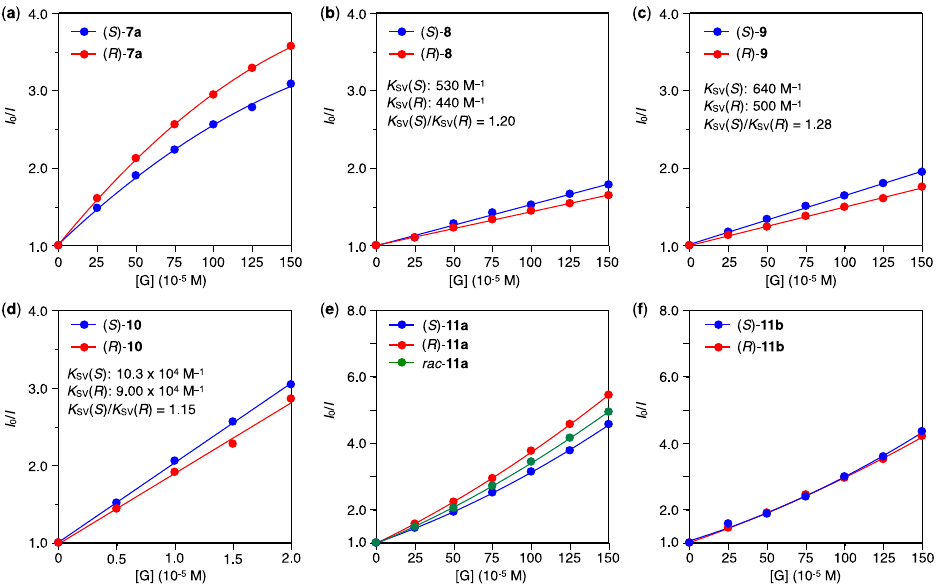
Figure 7. Stern–Volmer plots for the fluorescence quenching of CyD- 1b ( λ ex = 450 nm) by the ( R )- (red) and ( S )- (blue) isomers of 7a ( a ); 8 ( b ); 9 ( c ); 10 ( d ); 11a ( e ) and 11b ( f ) in hexane/THF (90/10, v / v ) at room temperature. The result using rac - 11a as a quencher is also shown in ( e ). [Glucose unit] = 1.0 × 10 − 5 M. The influence of the fluorescent terthienyl-based pendant on the chiral recognition was investigated by comparison of the chiral recognition abilities of Am- 1b and the previously reported amylose tris(phenylcarbamate) (ATPC in Figure 1), which contains non-substituted phenylcarbamate